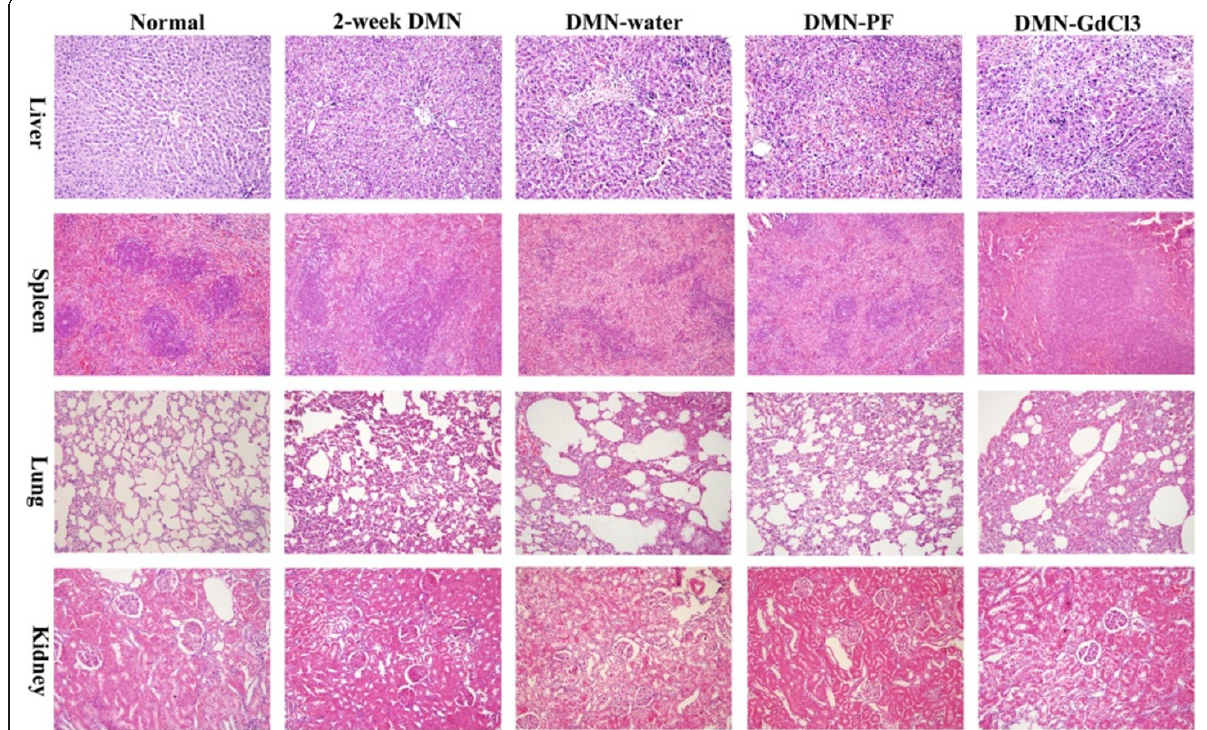
Figure 1 Effects of PF on H&E staining in different organs in DMN-induced rat liver fibrosis ×200